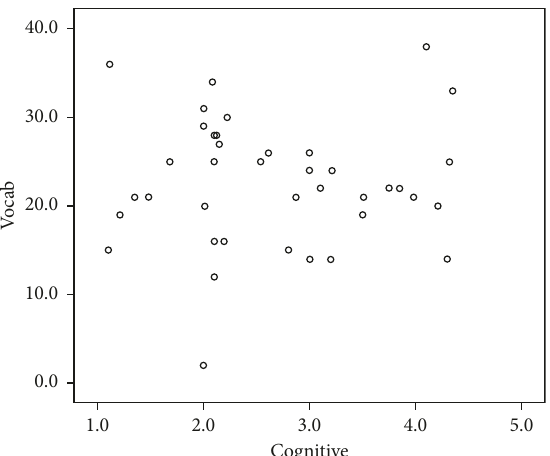
Figure 5: The relationship between vocabulary knowledge test and cognitive strategy use.